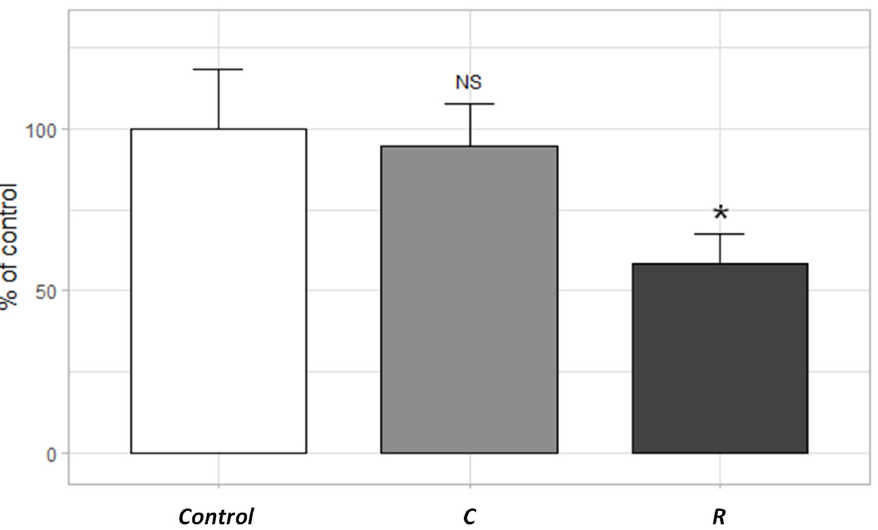
Figure 3. Inhibition of complex I of the mitochondrial respiratory chain induced by RR samples from the Compans (C) and Rosny (R) sites (2017-06-28 and 2017-09-14, respectively). Difference compared to control * = p -value < 0.05 (non-parametric Kruskal–Wallis test); NS = not significant.